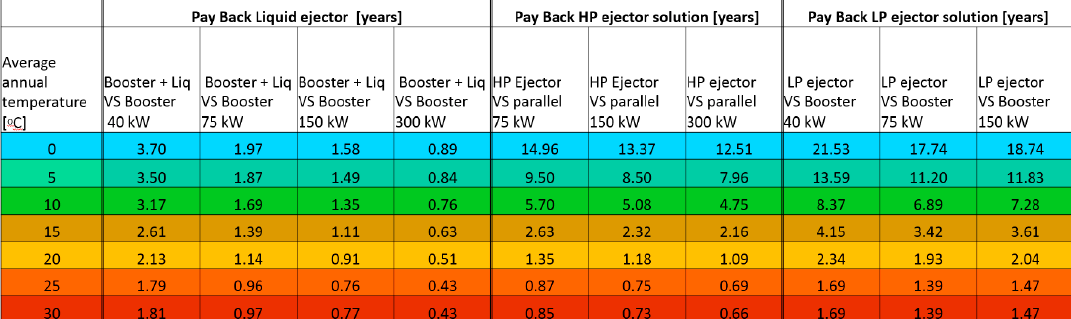
Figure 21. Payback period for ejector addition to various transcritical R744 booster supermarket refrigeration systems with respect to both the average annual temperature and the required cooling capacity [60].